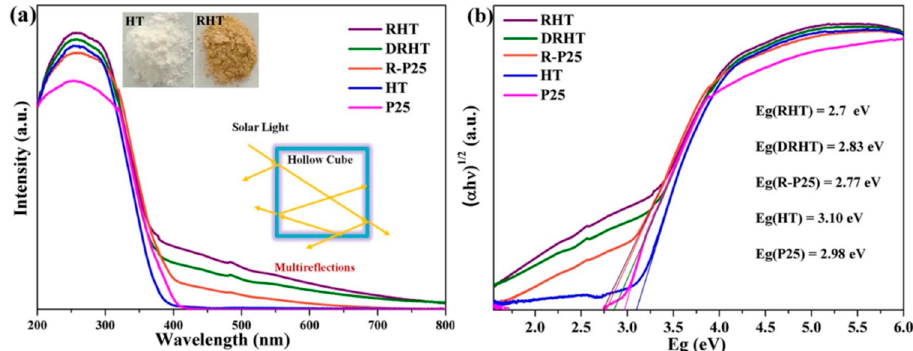
Figure 11. ( a ) UV–Vis diffuse reflectance spectra and ( b ) Tauc plot for band gap determination [73]. Copyright 2018 Springer Nature Publishing AG.